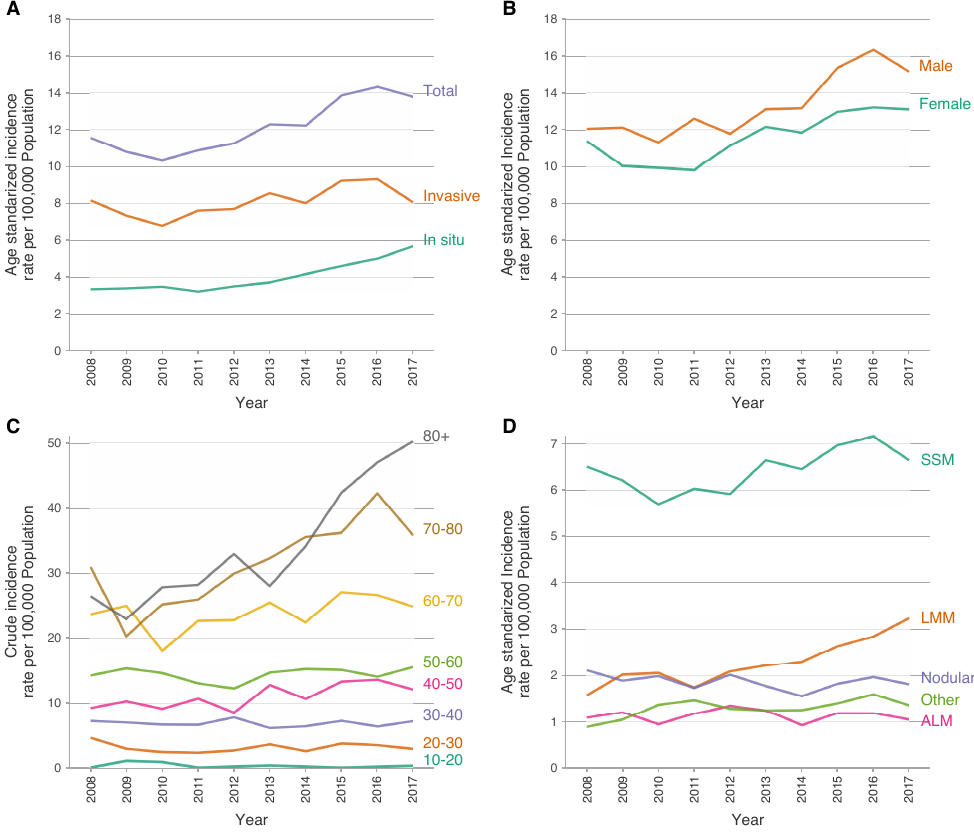
Figure 2. Trends in the incidence of melanoma in Catalunya. Abbreviations: ALM, acral lentiginous melanoma, LMM, lentiginous malignant melanoma; SSM, superficial spreading melanoma. Table 2. Incidence of melanoma in